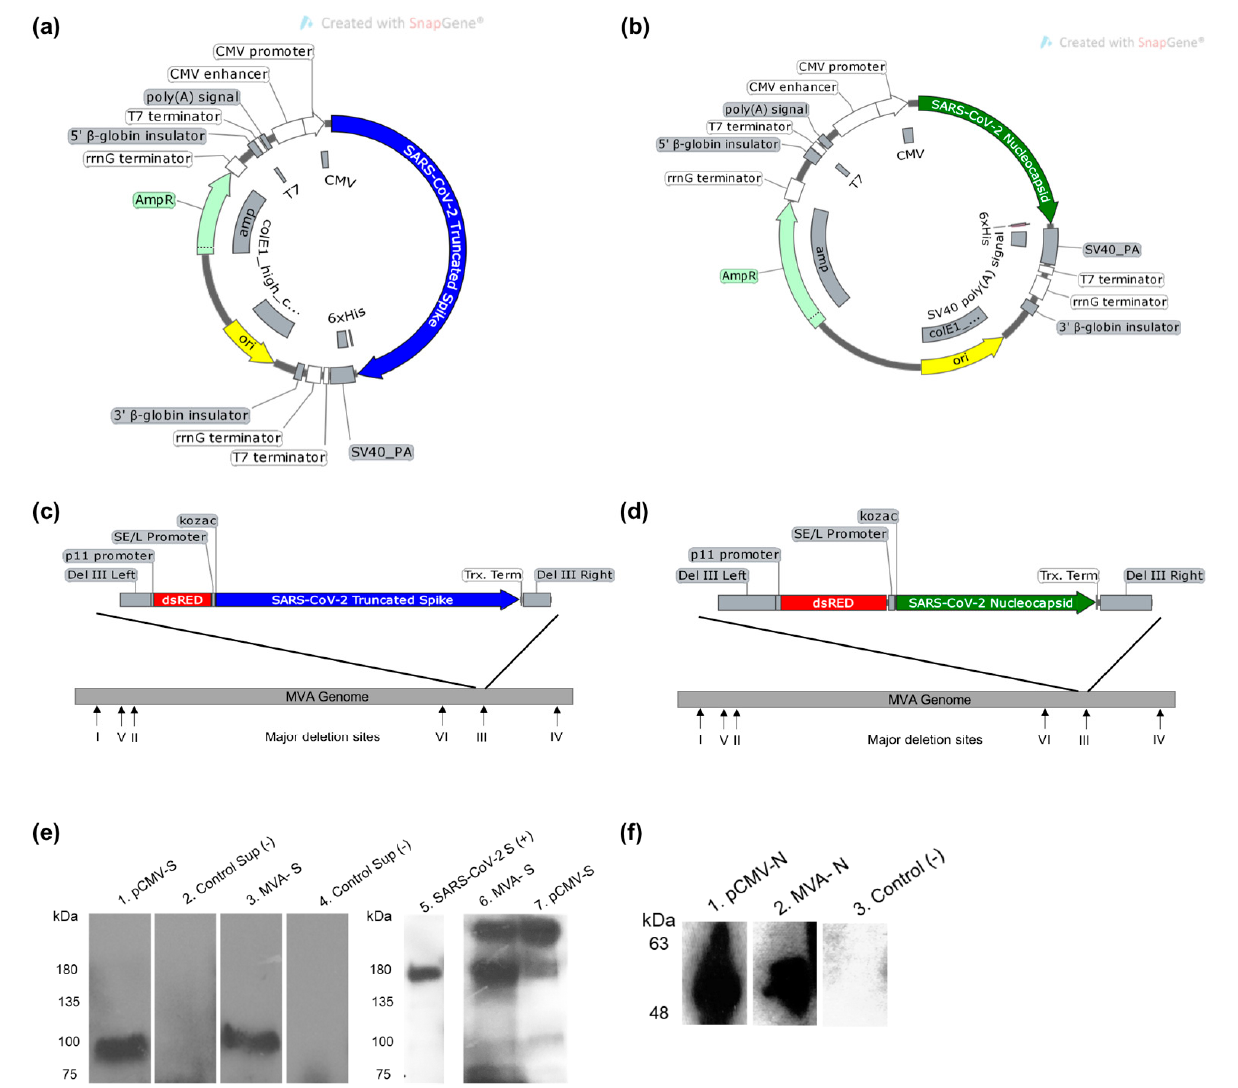
Figure 1. Design of SARS-CoV-2 vector vaccine constructs expressing S and N proteins. ( a ) Gene map of pCMV plasmid expressing Truncated S (TrS) protein. ( b ) Gene map of pCMV plasmid backbone expressing N protein. ( c ) MVA